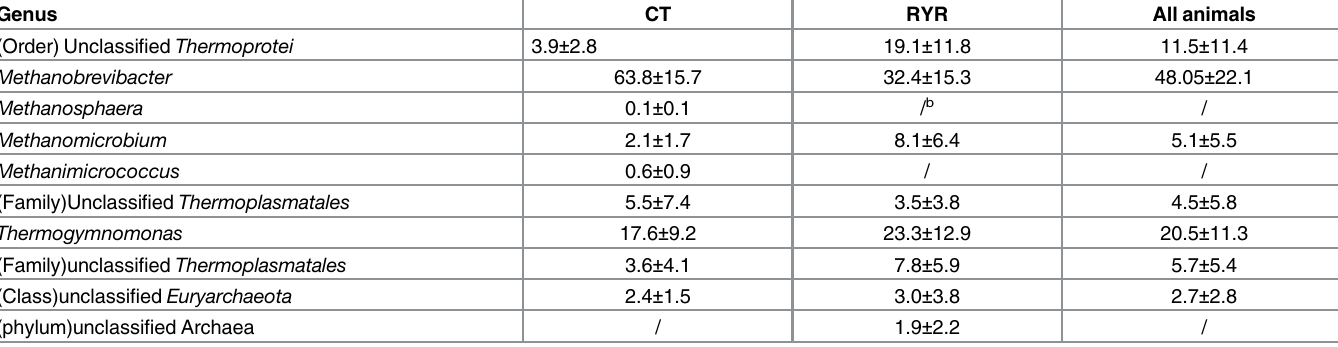
Table 9. The archaeal genera shared by CT group (n = 10), RYR group (n = 10) and all goats (n = 20) and their abundance (Means ± SD, % of sequences) a .